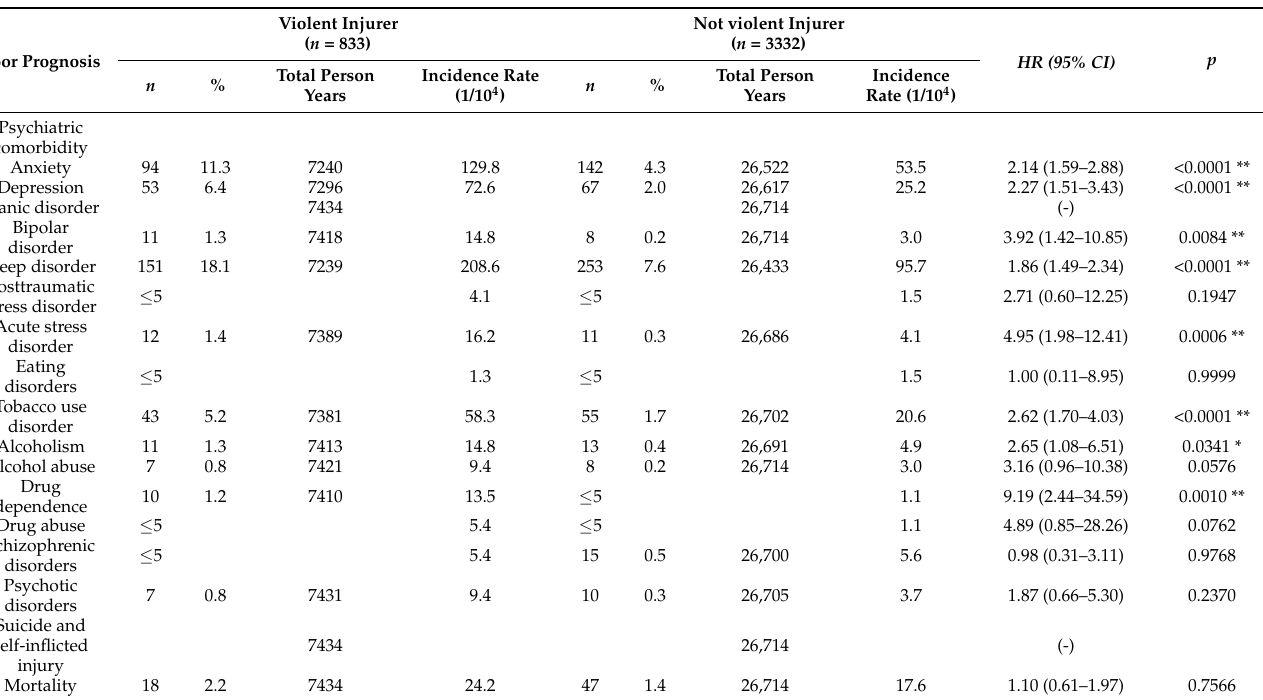
Table 3. Comparison of the risk of mental illness and poor prognosis between victims of violence and those without violence (children and adolescent,